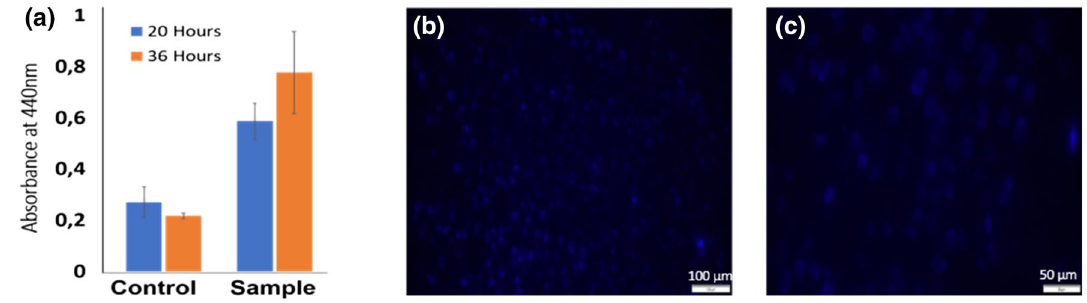
Fig. 3 a Spectrophotometer-measured absorbance of medium at 440 nm following 3.25-h sample incubation with WST-1. DAPI staining and fluorescence visualization of cells on substrate after 36 h of growth with b 20 × and c 40 ×